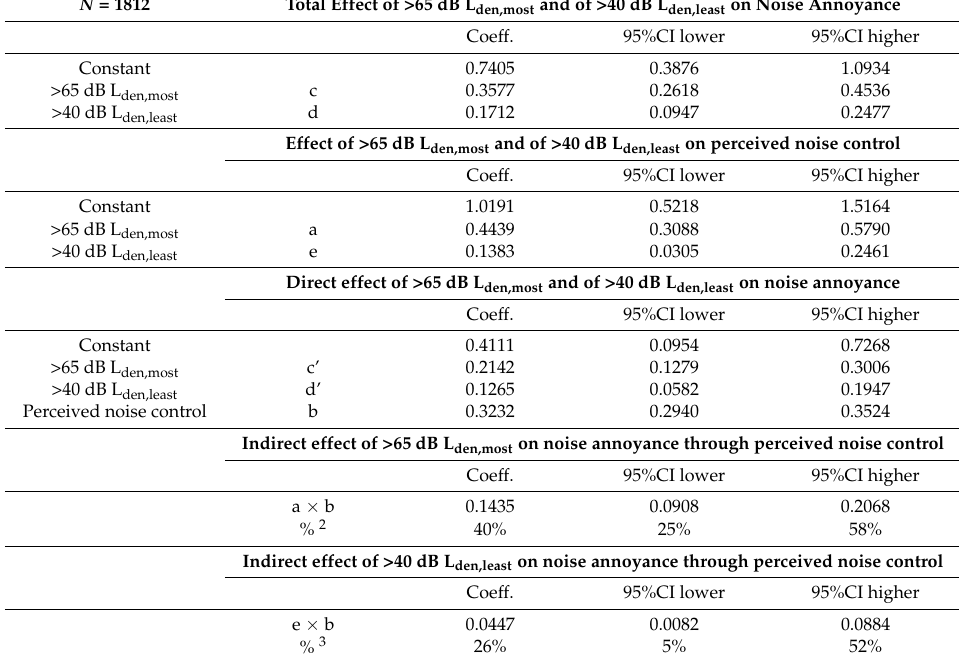
Table 6. Association of exposure to road traffic noise (>65 dB L den,most ) and absent quiet side (>40 dB L den,least ) with perceived noise control and noise annoyance 1